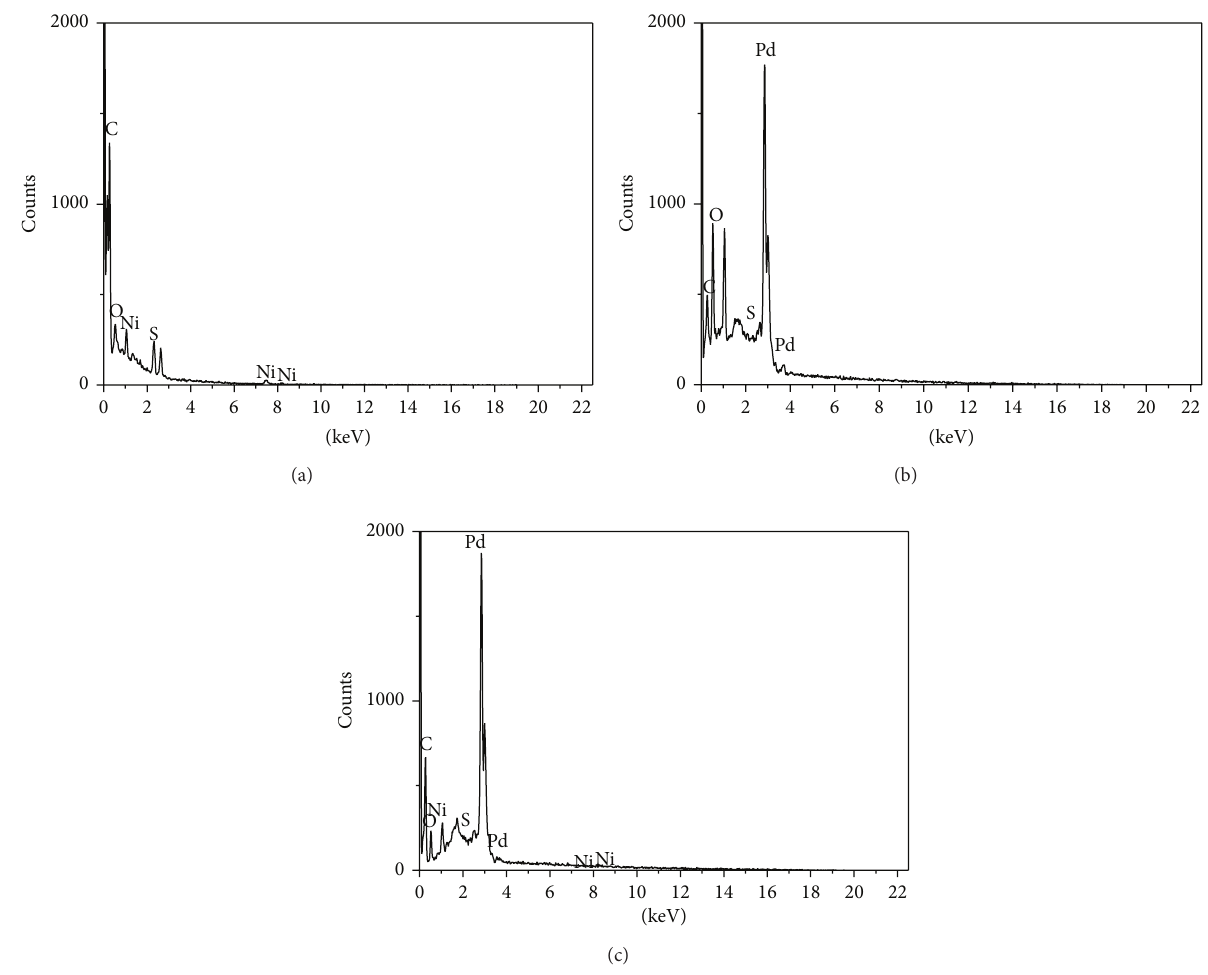
0.0 0.2 0.4 0.6 0.8 1.0